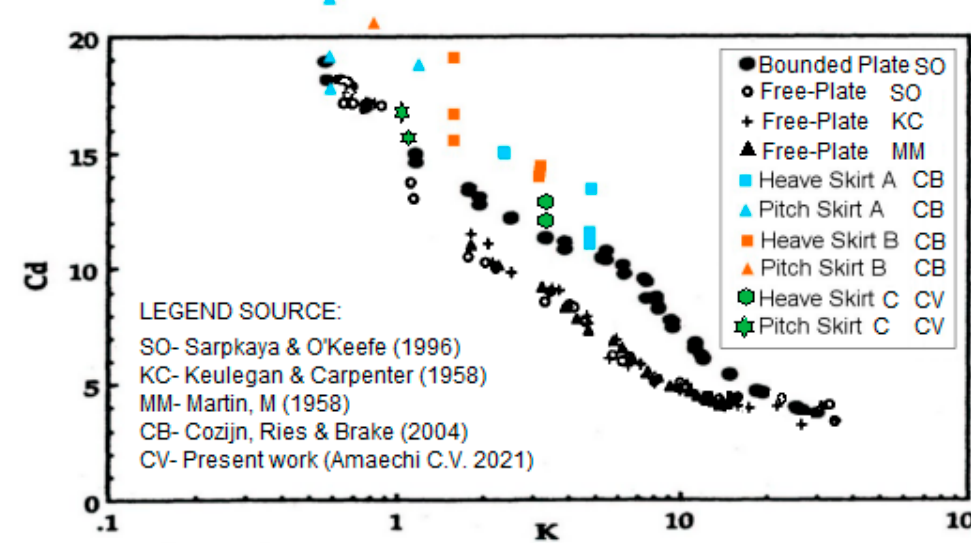
Figure 23. Drag coefficient versus Keulegan-Carpenter number for wall-bounded 2D plates and free rectangular 2D plates. (Please note that all the points are approximate interpolations. Also, the original graph was made by Sarpkaya and O’Keefe [53], as they created the black and white image, based on their own experiments with wall mounted plates in a flume tank. Cozijn et al. [51] added the orange and blue points, which are the data resulting from MARIN’s forced oscillation model experiments with a CALM buoy. Amaechi C.V. [26] added the green points from experiments using WITmotion bluetooth sensors on CALM buoy in Lancaster University wave tank. The image was adapted with permissions of ISOPE, MARIN and ASME. Original sources: [53], [51], and [26]).